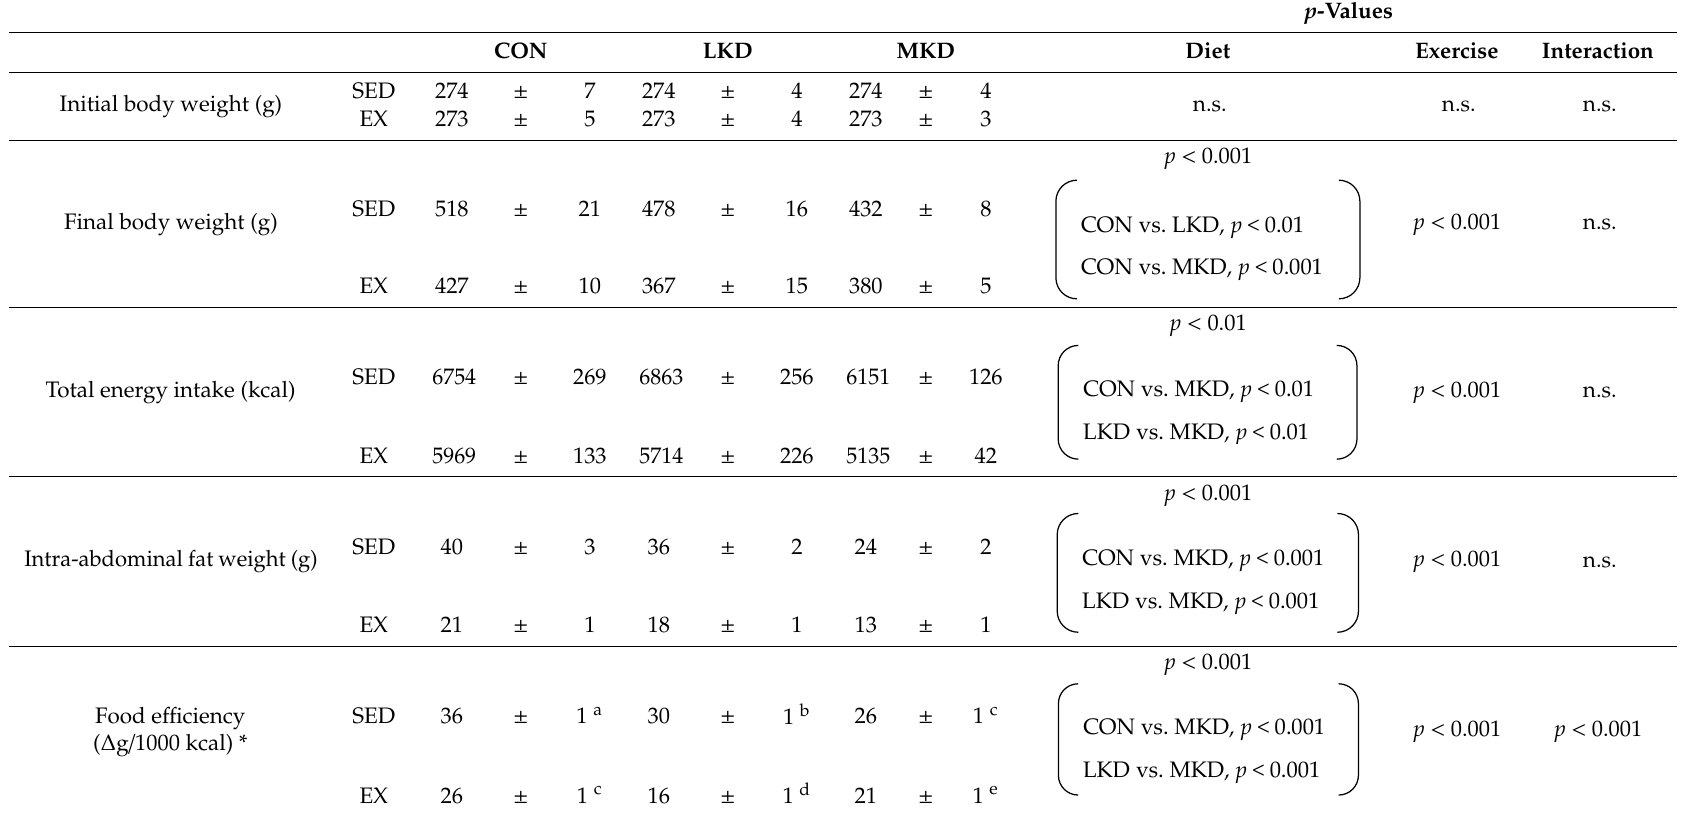
Table 3. Body weight, total energy intake, intra-abdominal fat weight, and food efficiency in rats.